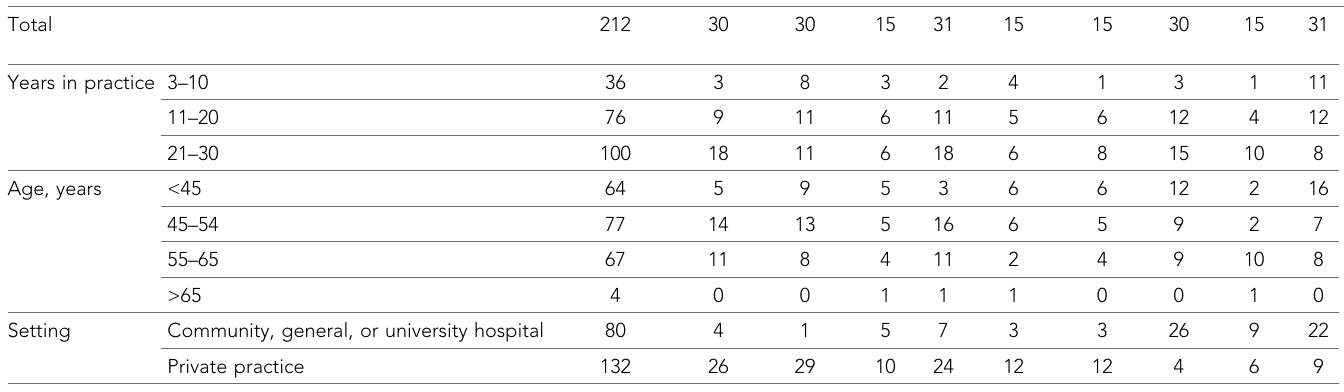
Table 1. Distribution of responders by country, years in practice, age range, and